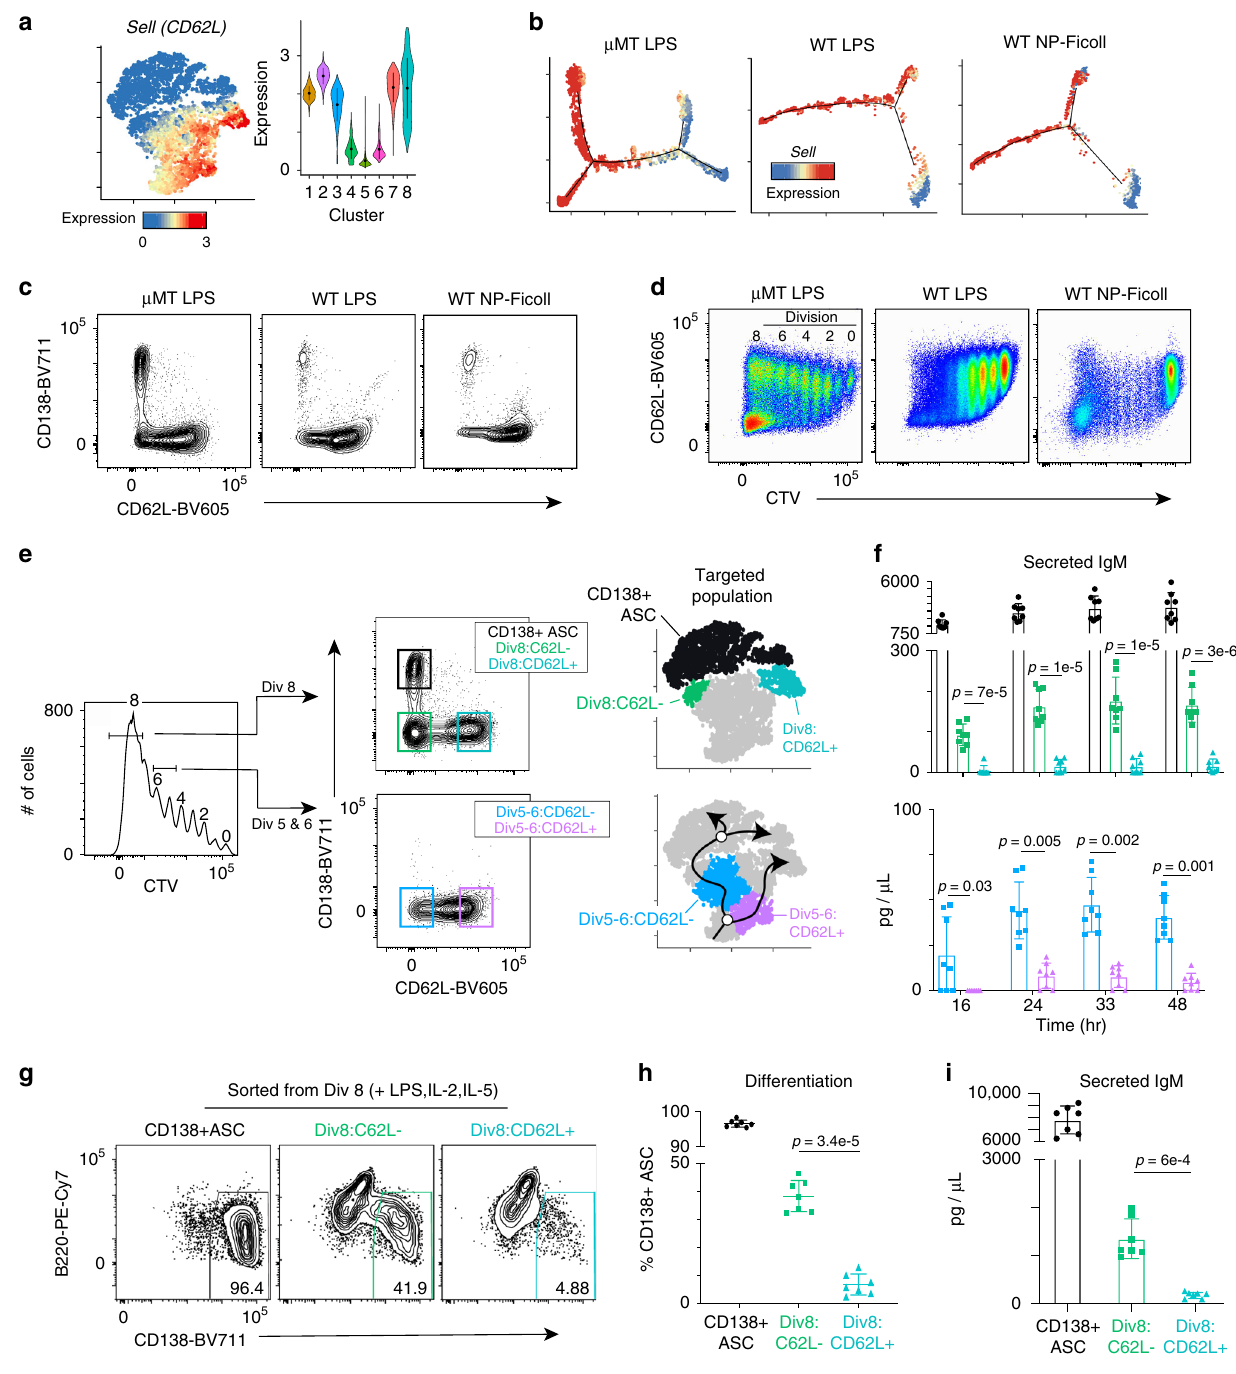
Fig. 7 Loss of CD62L (L-selectin) delineates cells on the ASC-destined branch. a t -SNE plot (left) from Fig. 4a and violin plot (right) for each cluster showing the MAGIC gene expression data for Sell (CD62L) in WT cells. For violin plots, the dots represent mean and lines represent fi rst and third quartile ranges. b Sell expression projected along pseudotime for each scRNA-seq dataset (see Fig. 5c). c Representative fl ow cytometry plot of CD138 versus CD62L for adoptively transferred cells from μ MT hosts challenged with 50 μ g of LPS (left), WT hosts challenged with 50 μ g of LPS (middle), or WT hosts challenged with 50 μ g of NP-Ficoll (right). All plots are 72 h after challenge. d Representative fl ow cytometry plot of CD62L versus CTV for each adoptive transfer setup described in ( c ). The division number is indicated in the left panel. e Representative FACS strategy for isolating ASC in clusters 5 and 6 (CD62L – CD138 + cells), ASC-destined cells in cluster 4 (div8:CD62L – CD138 – ), non-ASC-destined cells in cluster 8 (div8:CD62L + CD138 – ), ASC-destined cells in cluster 3 (CD62L – CD138 – ), and non-ASC-destined cells in cluster 2 (CD62L + CD138 – ). Cells were gated on division 5, 6, or 8 and then separated by CD138 and CD62L expression 72 h post LPS challenge. f IgM titers in culture over time for the indicated samples from division 8 (top) and divisions 5 and 6 (bottom). g Representative fl ow cytometry plot of B220 versus CD138 expression after 16 h of culture with LPS, IL-2, and IL-5 for the indicated samples. Percent of CD138 + ASC is indicated. h Percent of CD138 + cells and i IgM titers in culture for each sample. Data in ( f , h , i ) represent mean ± SD. Statistical signi fi cance in ( f , h , i ) was determined by paired two-tailed Student ’ s t tests. Data in ( f ) represent two independent experiments with a total of eight mice; data in ( g – i ) represent two independent experiments with a total of seven mice. Source data are provided as a Source Data fi